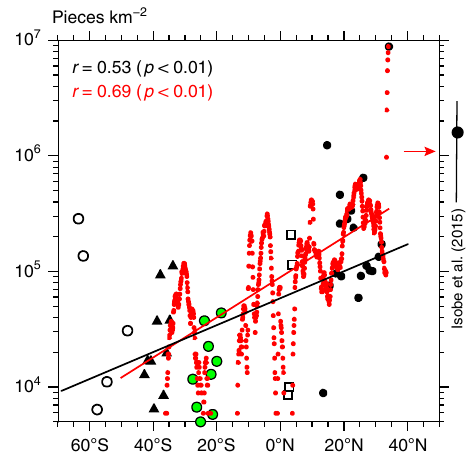
Fig. 4 Observed and modeled microplastic abundance. The modeled total particle counts are shown by the small red dots along 140 (160)°E in the North (South) Paci fi c. To compare the modeled abundance with the observed abundance, the modeled total particle count in the grid cell nearest to Sta. 38 was adjusted to that observed at Sta. 38 (see Numerical modeling in the Methods section). The total particle counts in the modeled area north of 30°N were averaged (red arrows) to compare them with the estimate provided by Isobe et al. 7 . The closed circle and bar on the right- hand side of this fi gure denote the average and standard deviation of total particle counts observed around Japan >30°N,